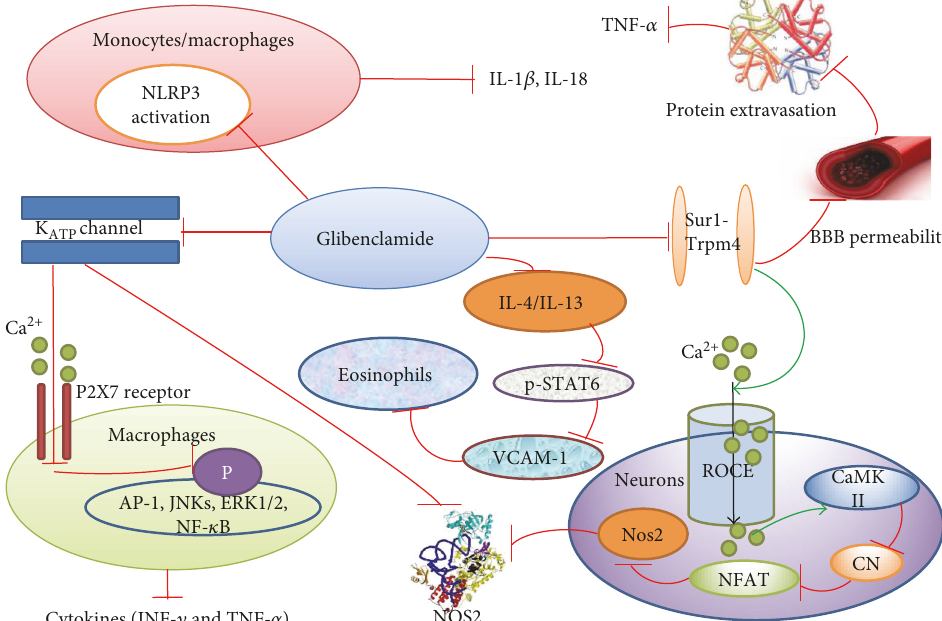
Figure 1: Anti-in fl ammatory mechanisms of glibenclamide. Glibenclamide blocks KATP channel to prevent K + e ffl ux and changes the membrane potential, which inhibits P2X7 receptor-mediated Ca 2+ in fl ux, resulting in reducing in fl ammatory cytokines. Glibenclamide blocks the Sur1-Trpm4 channel to decrease the BBB permeability, which reduces extravasated protein-induced production of TNF- α . Glibenclamide inhibition of Sur1-Trpm4 channel increases ROCE-mediated Ca 2+ in fl ux, which activates CaMKII and then inhibits CN/ NFAT/Nos2 signaling. Glibenclamide can inhibit NLRP3 in fl ammasome-mediated production of IL-1 β and reduce IL-13/4, which blocks the migration of eosinophils. The inhibitory e ff ect is indicated by red lines with bar ends; the excitatory e ff ect is indicated by green lines with arrow ends. ROCE: receptor-operated Ca 2+ entry channel; CaMKII: Ca 2+ /calmodulin protein kinase II; CN: calcineurin; NFAT: nuclear of activated T cells; Nos2: inducible nitric oxide synthase gene; AP-1: activator protein-1; ERKs: extracellular signal-regulated kinases; JNKs: Jun N-terminal kinases; BBB: blood-brain barrier; p-STAT6: phosphorylated signal transducer and activator of transcription 6; VCAM-1: vascular cell adhesion molecular